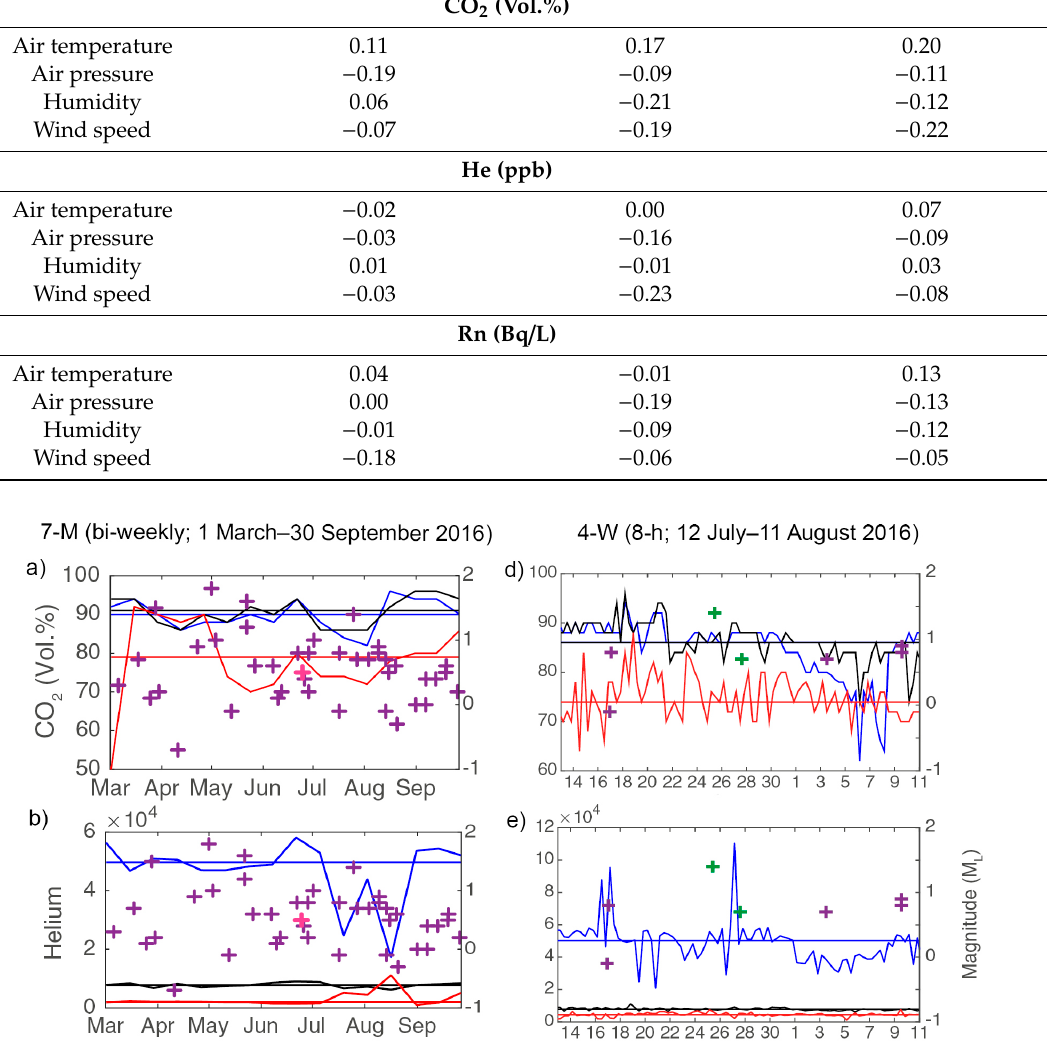
Table A3. Coefficients of raw data of weather variables (air temperature, air pressure, wind speed, humidity) with geogenic gas concentrations for CO 2 , He, and Rn for the mineral springs during the 4-W sampling.